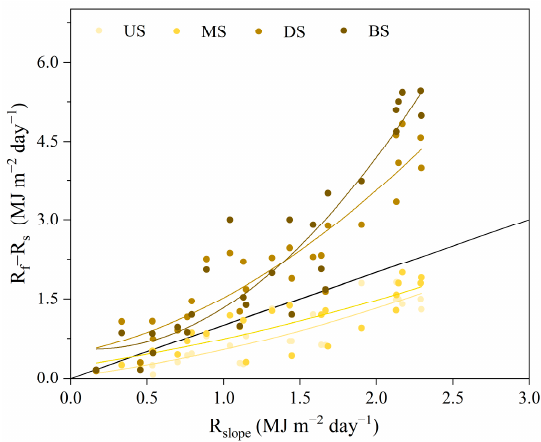
Figure 5. Comparison of the slope effect and the shaded terrain effect at different slope positions. R slope represents the slope effect (i.e., R h — R f ).